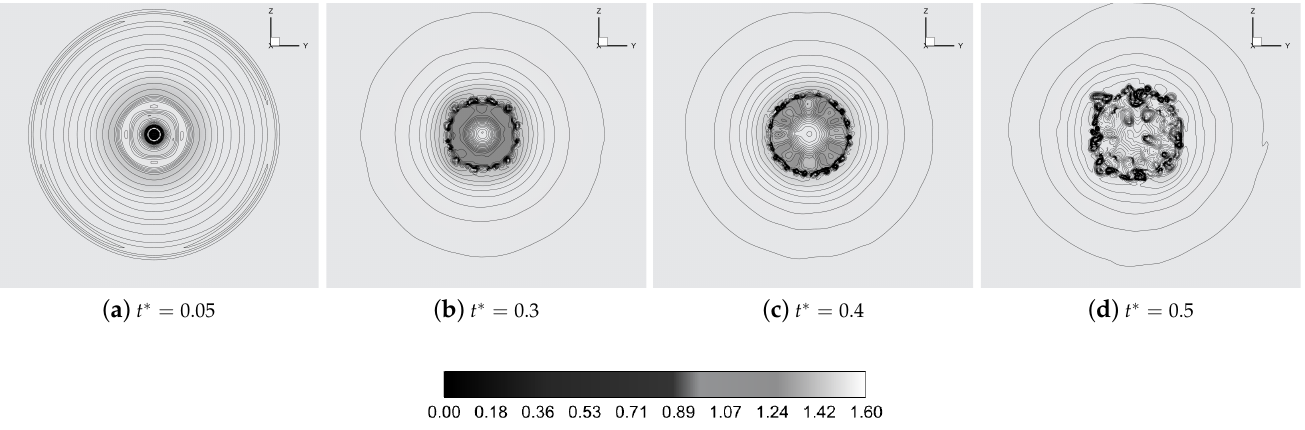
Figure 5. Contour plots for the normalized density of the gas phase depicted in the plane x / d 0 = 1, at four typical time